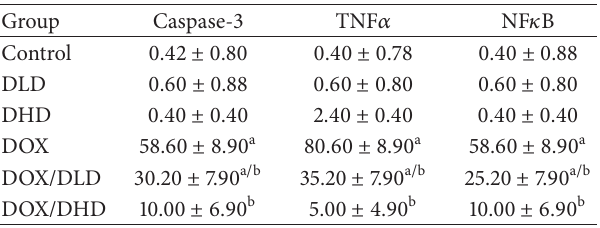
Table 4: The effect of DLD and DHD doses on caspase-3, TNF 𝛼 , and NF 𝜅 B immune